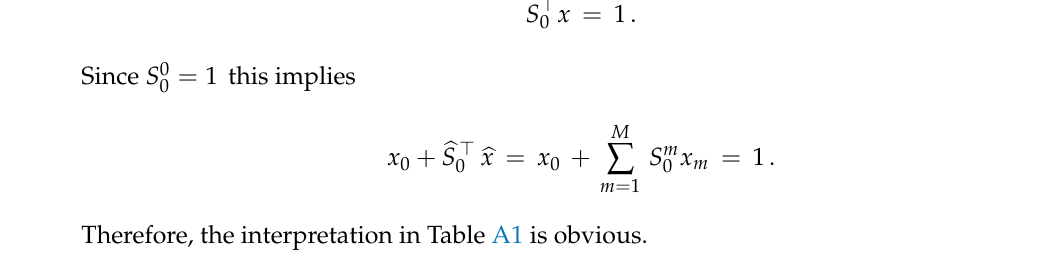
Table A1. Invested capital portions.